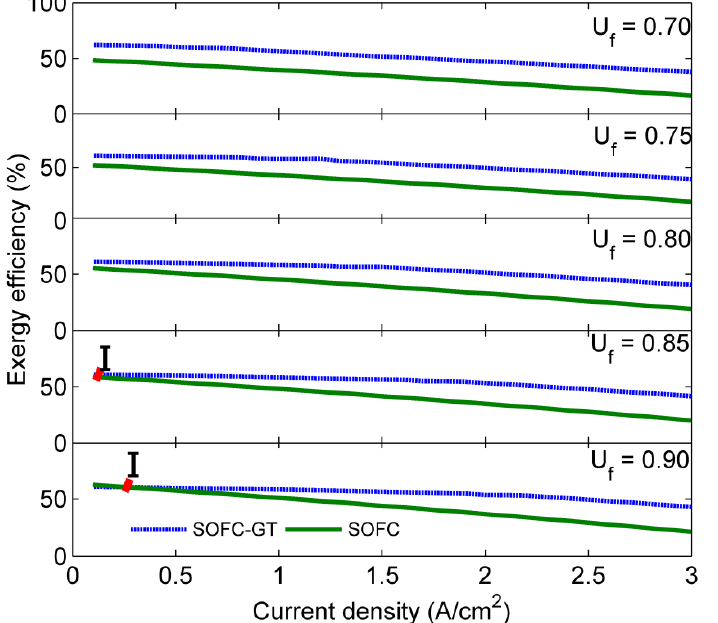
Figure 4. The effect of current density at specific values of fuel utilization factor on exergy efficiency of both systems; T = 600 FC